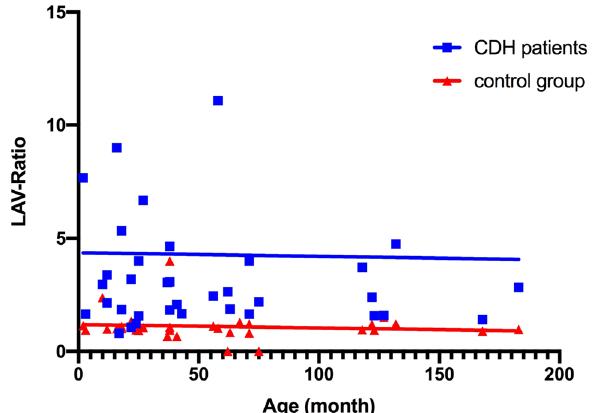
Figure 4. Age dependent comparison of LAV ratio between CDH patients and control group. Low attenuating volume (LAV) ratio between ipsilateral and contralateral lung remains constant over time both for CDH patients and control group. A highly significant difference is seen between both groups, meaning that LAV ratio in CDH patients is increased in comparison to that of the control